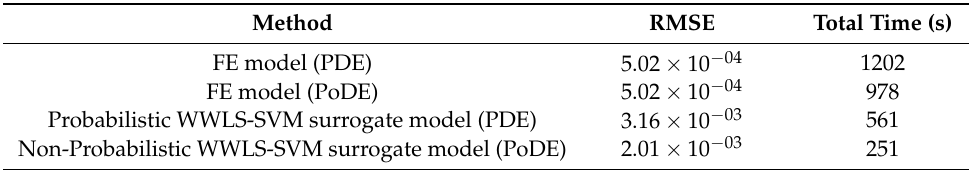
Table 4. Comparison the results in terms of computational cost and accuracy.